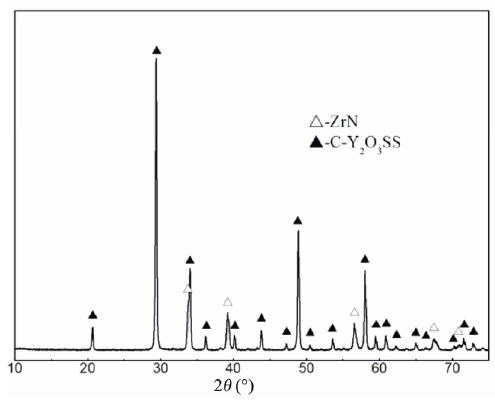
Fig. 7 XRD pattern of the sample with ZrN:ZrO 2 :Y 2 O 3 = 4:1.2:4.8.